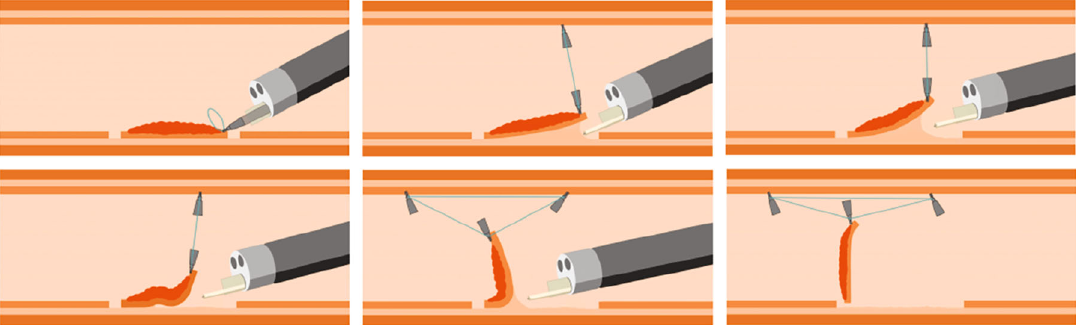
Figure 4: The traction e ff ect might decrease as dissection progresses during endoscopic submucosal dissection. In such cases, an additional clip can be applied to strengthen the